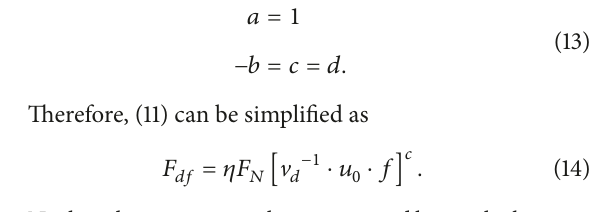
algorithm, improved genetic algorithm, and particle swarm algorithm, are commonly utilized for the identification of model dynamic